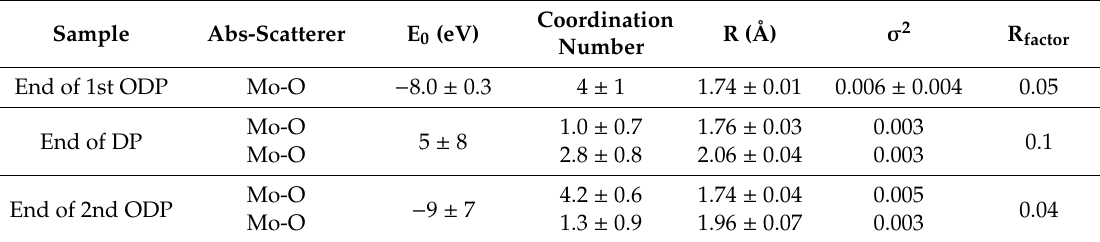
Table 1. Extended X-ray Absorption Fine Structure (EXAFS) fitting parameters 1 for the spectra collected at the end of step of the reaction